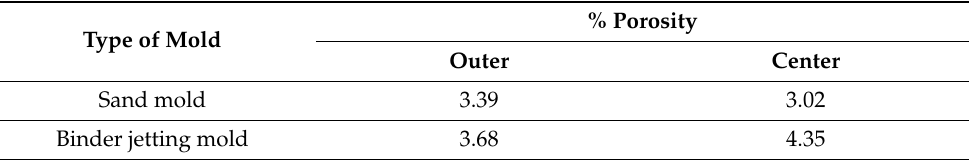
Table 4. % Porosity of casting specimens solidified in sand mold and binder jetting mold. Type of Mold